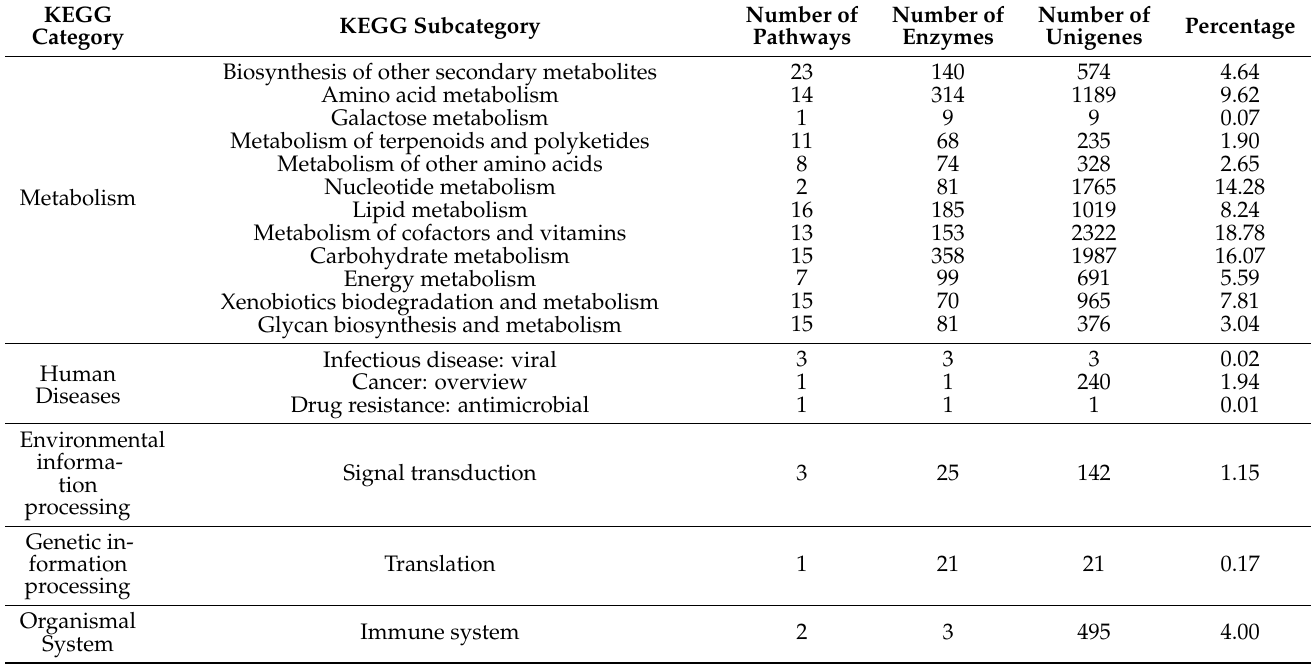
Table 3. Number of enzymes and unigenes in B. koreana based on KEGG